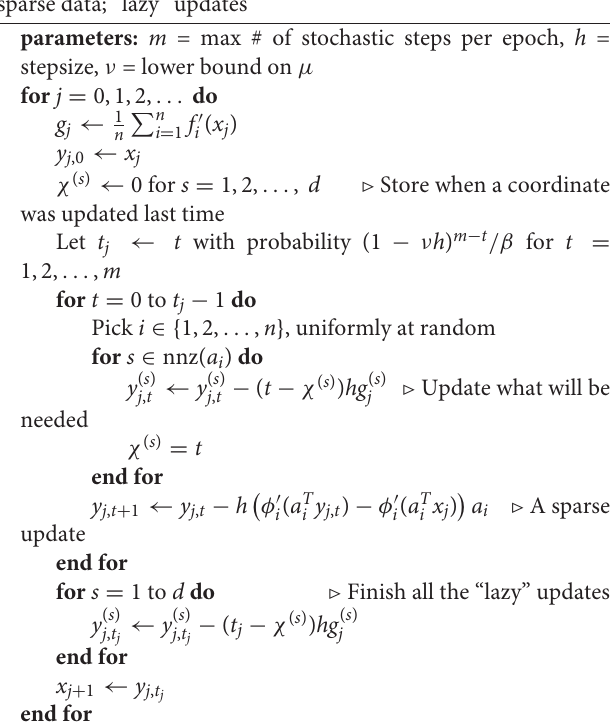
Algorithm 3 Semi-Stochastic Gradient Descent (S2GD)